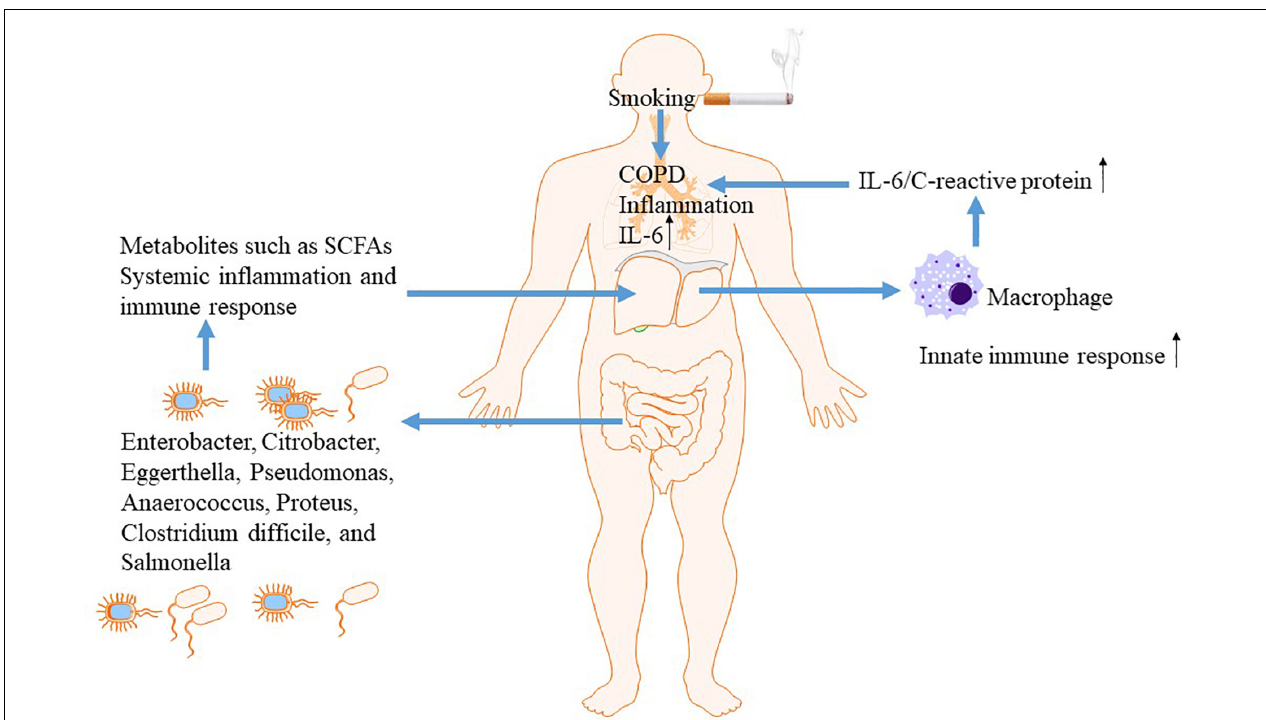
FIGURE 3 | The gut-liver-lung axis in